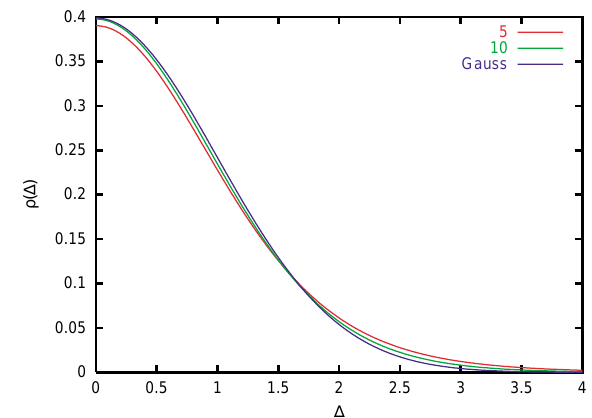
FIG. 3. (Color) The bare tune distributions for five- and ten-term Gaussian series with s G (cid:1) 1 . A Gaussian distribution with unit standard deviation is shown as well.